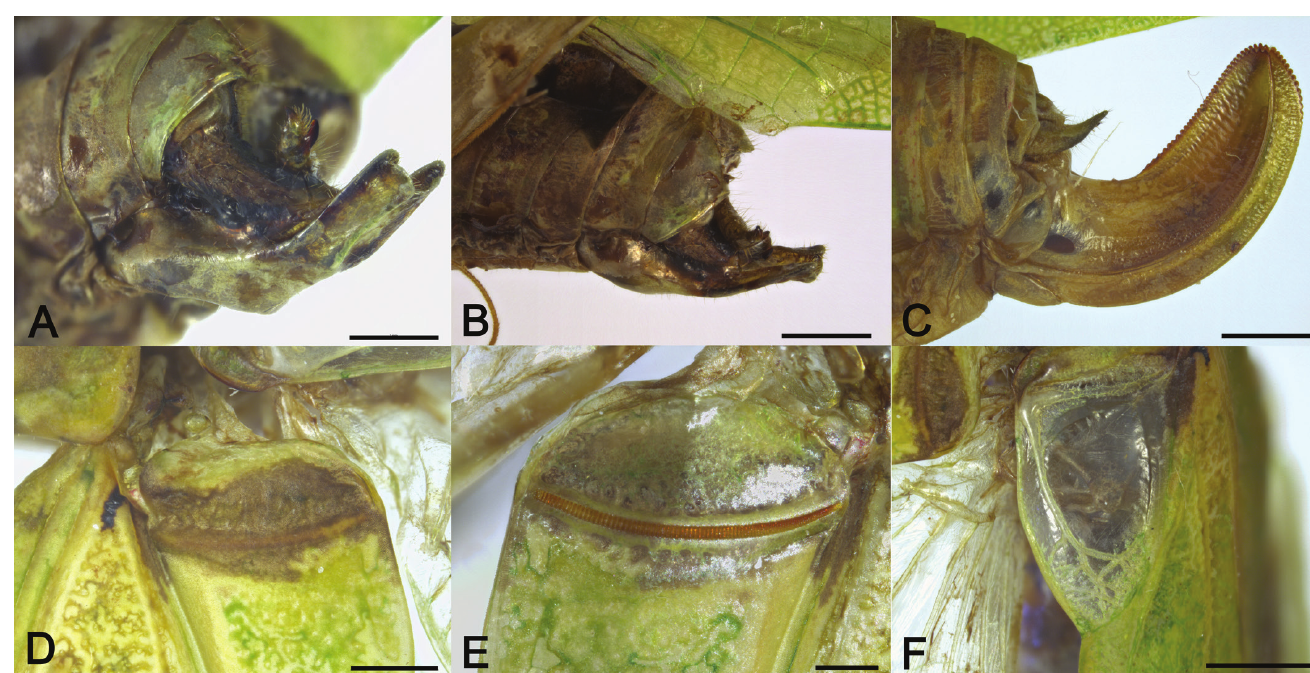
Fig. 2. Morphological details of Lunidia bicercata sp. n. A, B. Semilateral view on male abdominal apex; C. Ovipositor of female; D. Stridulatory area on left tegmen of male; E. Male stridulatory file, inner side left tegmen; F. Mirror on right tegmen of male. A, C, D, F. Scale bars: A, B. 1 mm D, E. 0.5 mm C, F. 2